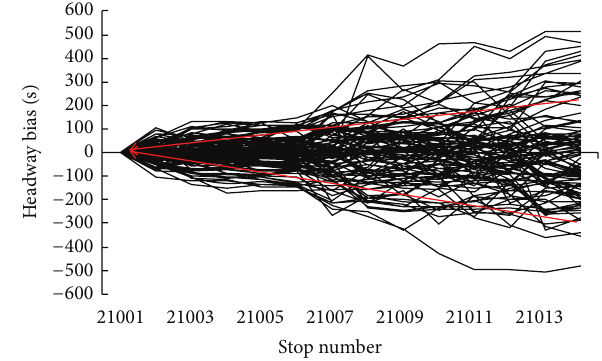
Figure 1: Headway deviation with buses traveling on the route (control